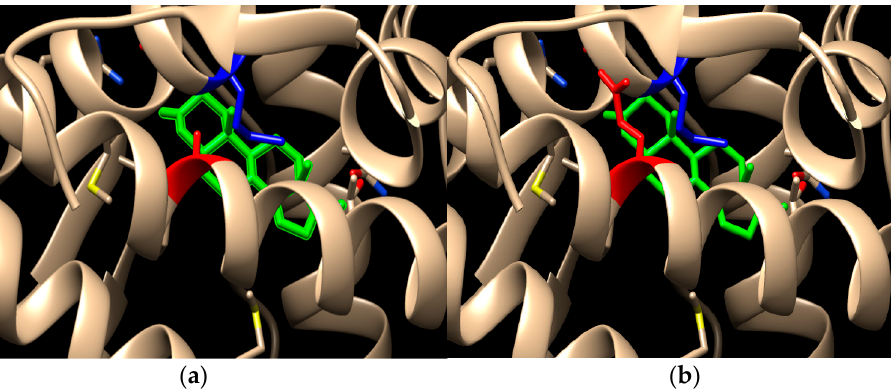
Figure 3. Amino acid changes between wild type AR ( a ) and Ala871Glu mutated protein ( b ) (Red- amino acid 871, blue-Met743, green-DHT).